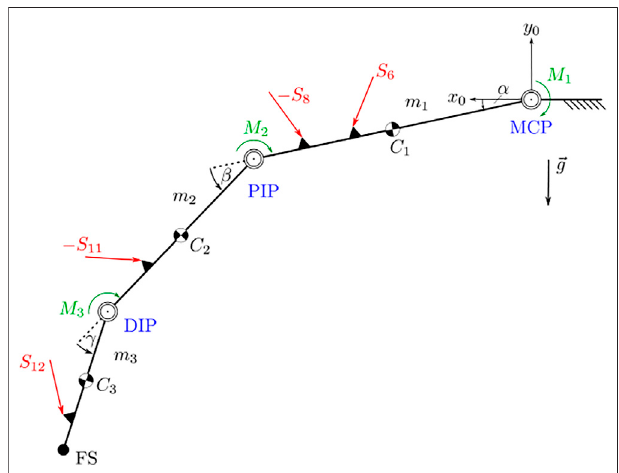
FIGURE6| Dynamic modeloftheunconstrained fi nger.The fi nger joints are marked in blue. Areas marked in black are considered as rigid bodies within the structure. External forces are marked in red.